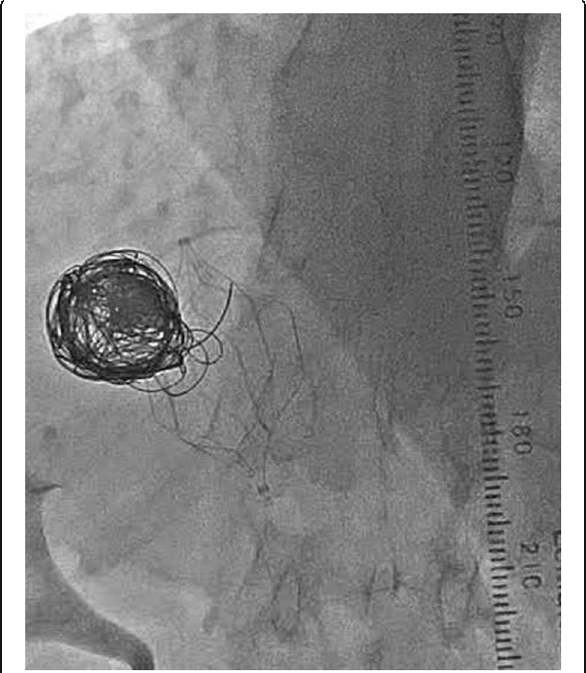
Fig. 4 Coil embolization successfully performed using 18